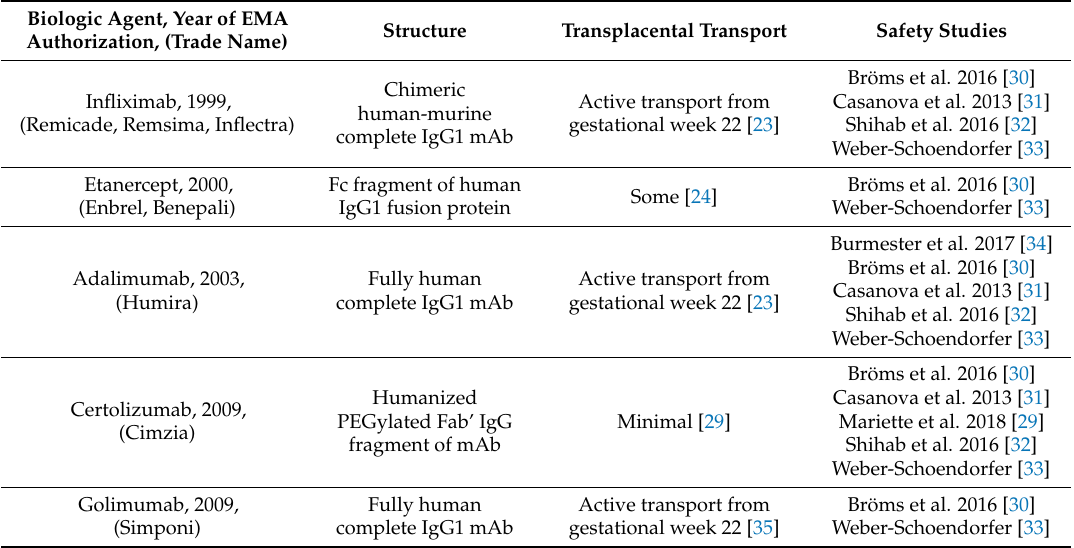
Table 1. Summary of Tumor Necrosis Factor inhibitorsstructure, transplacental transport, and safety studies in